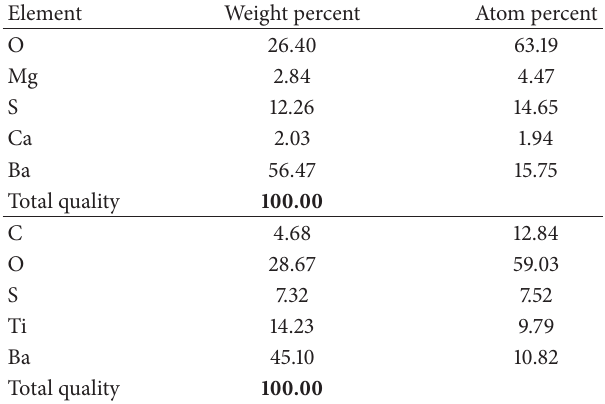
Table 1: EDS energy spectrum of naked barite and